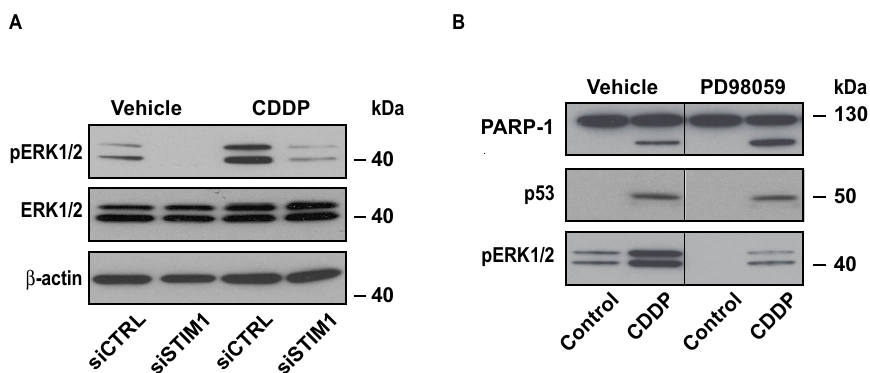
Figure 5. Effect of STIM1 depletion on ERK1/2 phosphorylation induced by CDDP. ( A ) Immunoblot analysis showing the effect of 24 h treatment with 25 µM CDDP on pERK1/2 in siCTRL or siSTIM1 transfected cells. ( B ) Immunoblot analysis showing the effect of 50 µM PD98059 of PARP-1 cleavage and p53 accumulation induced by 24 h treatment with 25 µM CDDP. Lanes separated by a thin line have been cropped from the same immunoblot.